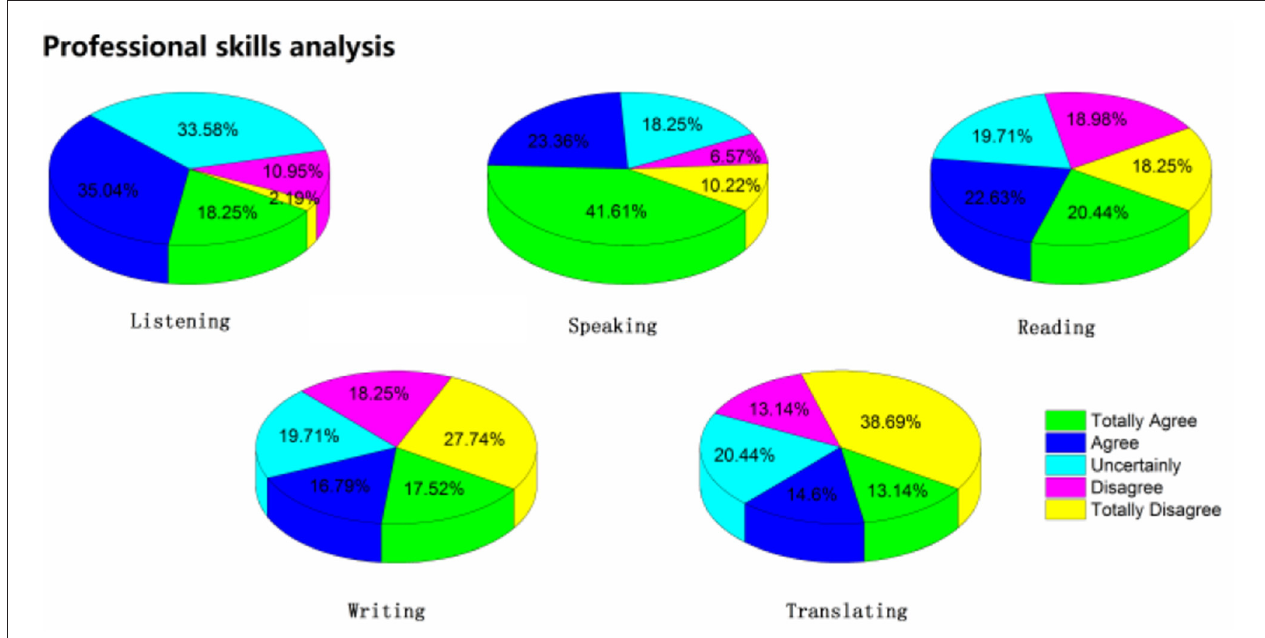
FIGURE 3 | The statistics of students’ anxiety in language skills.